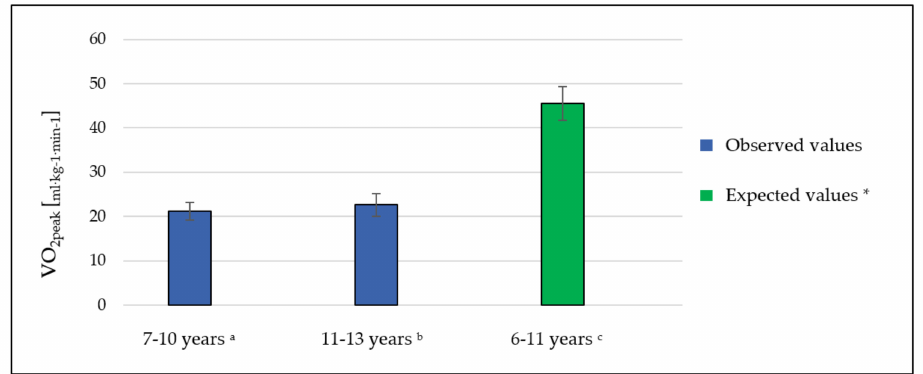
Figure 2. The values of VO 2peak in the study group with the division into age groups (children aged 7–10 and 11–13 years) compared to the values predicted in the relevant age group. Unpaired t -test: a examined boys versus expected values p < 0.0001, b examined girls versus expected values p < 0.0001, and c general study group versus expected values p < 0.0001. * Based on age- and sex-predicted values